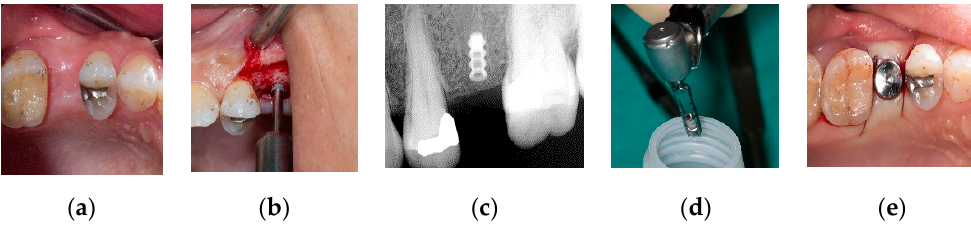
Figure 4. Surgical placement of micro-implant. ( a ). Initial situation with one missing tooth on maxillary second pre-molar area; ( b ). Full thickness flap raised and micro implant was inserted; ( c ). Periapical radiograph immediately after the surgery; ( d ). Trephine bur was used to retrieve